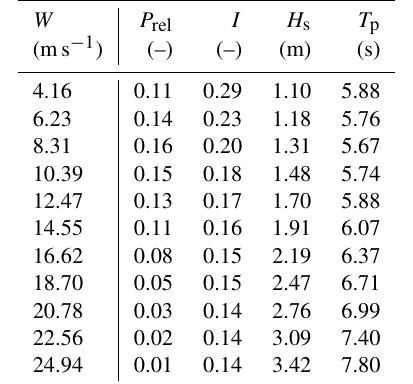
Table 1. The wind speeds and the corresponding probability of oc- currence, turbulence intensity, and sea states for load case 1.2. W P